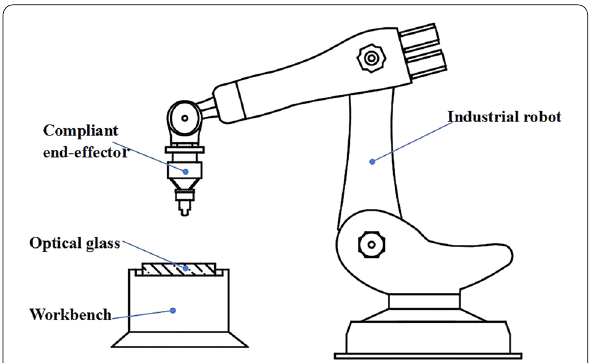
Figure 1 Diagram of polishing robot